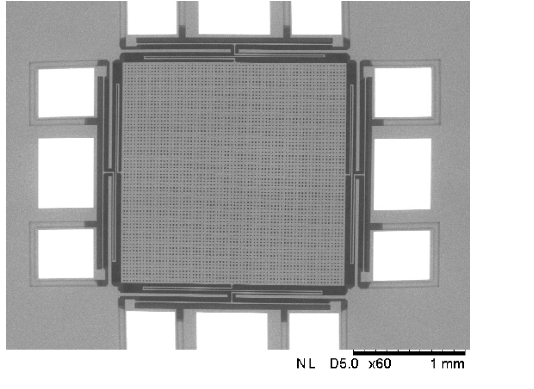
7 of 13 Figure 7. The chip fabrication flow. The sensor chip was fabricated as below: (a) Silicon doping: The top surface of the silicon layer was doped by depositing a phosphor silicate glass (PSG) layer and annealing at 1050 °C for 1 h in argon. The PSG layer was then removed via wet chemical etching; (b) Pad metal liftoff: The padded metal was deposited over the device layer by e-beam evaporation; (c)